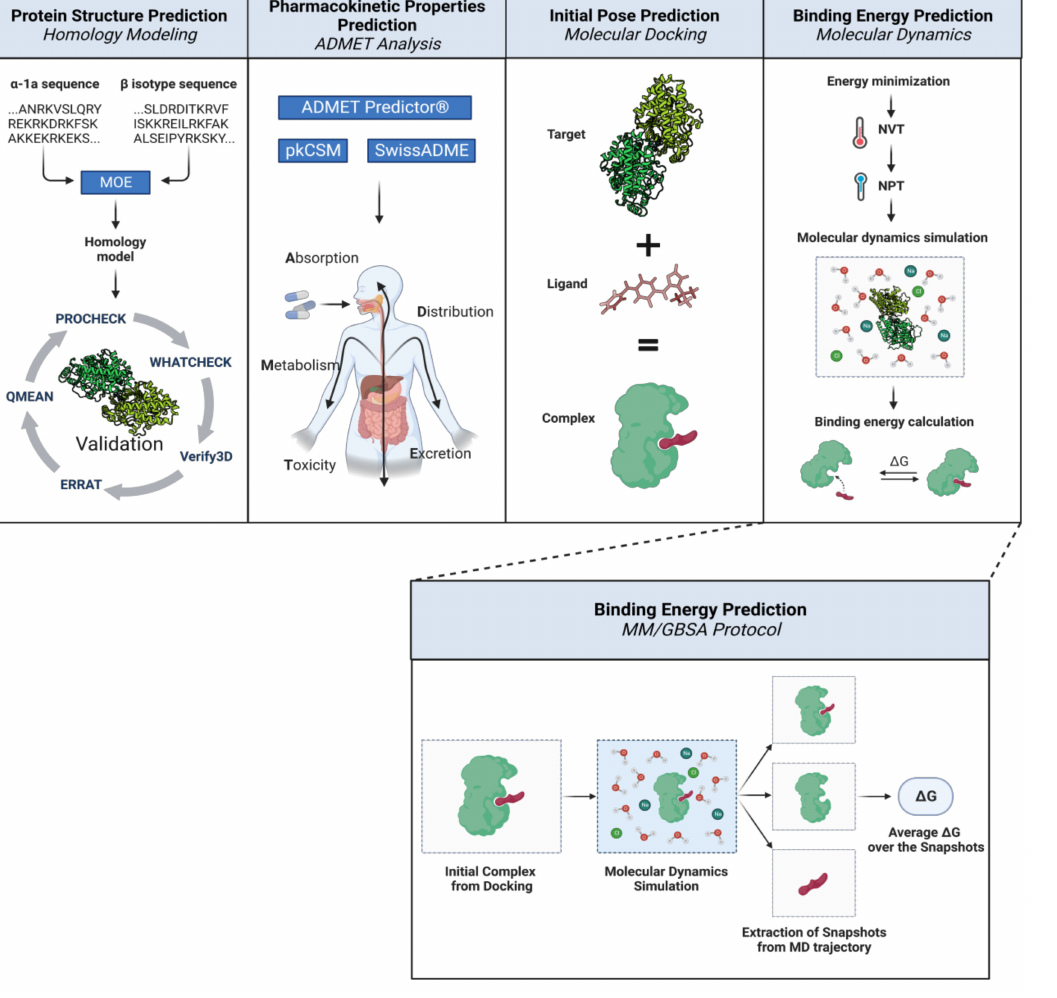
Figure 4. General scheme of the adopted methods for α - β dimers. First, a library of human tubulin models was obtained through homology modeling. The ligands were investigated in terms of